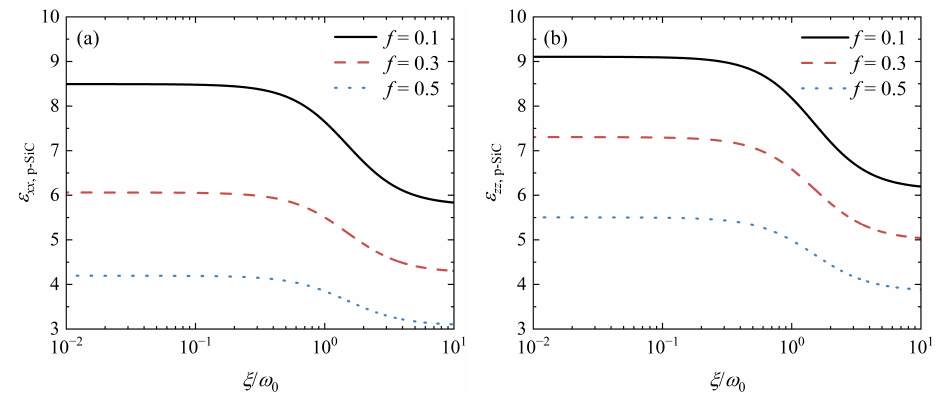
Figure 7. ( a ) ε xx ,p − SiC and ( b ) ε zz ,p − SiC as a function of ξ for different filling factors f